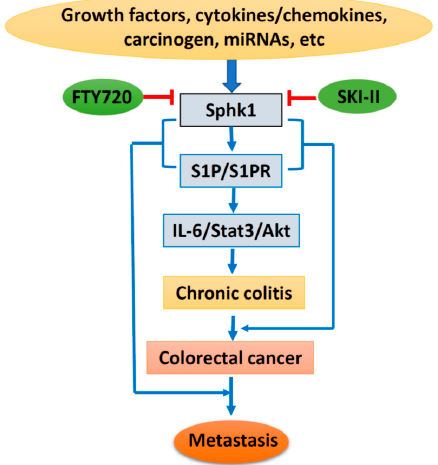
Figure 2. Schematic diagram of Sphk1/sphingosine-1-phosphate (S1P) signaling in colorectal carcinogenesis and progression. IL-6, interleukin 6; State3, signal transducer and activator of transcription 3; Akt, protein kinase B; SKI-II, sphk1 inhibitor.